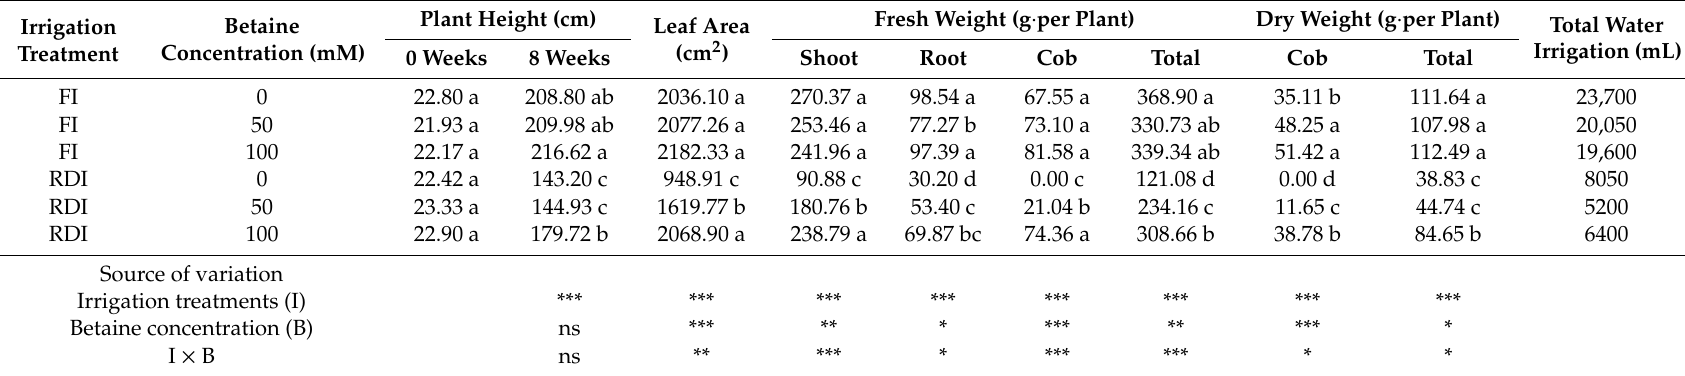
Table 1. E ff ects of di ff erent concentrations of betaine on the agronomic performance of maize under full irrigation (FI) and regulated deficit irrigation (RDI). Irrigation Treatment